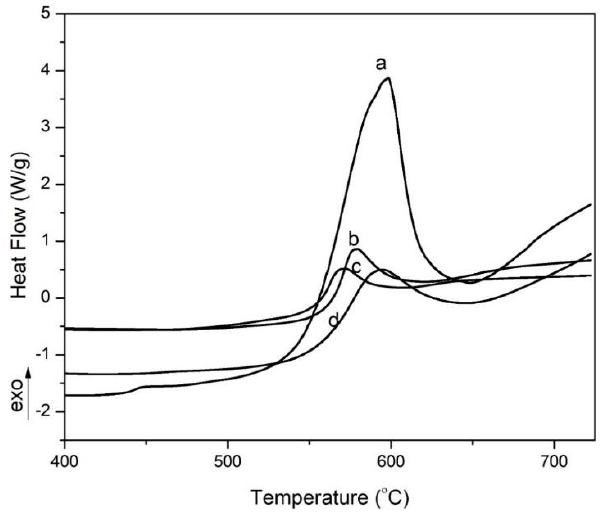
Figure 6. DSC thermograms obtained in nitrogen: ( a ) neat polyimide; ( b ) PI-30 wt.% grapheme; ( c ) PI-50 wt.% grapheme; ( d ) PI-10 wt.% graphene.